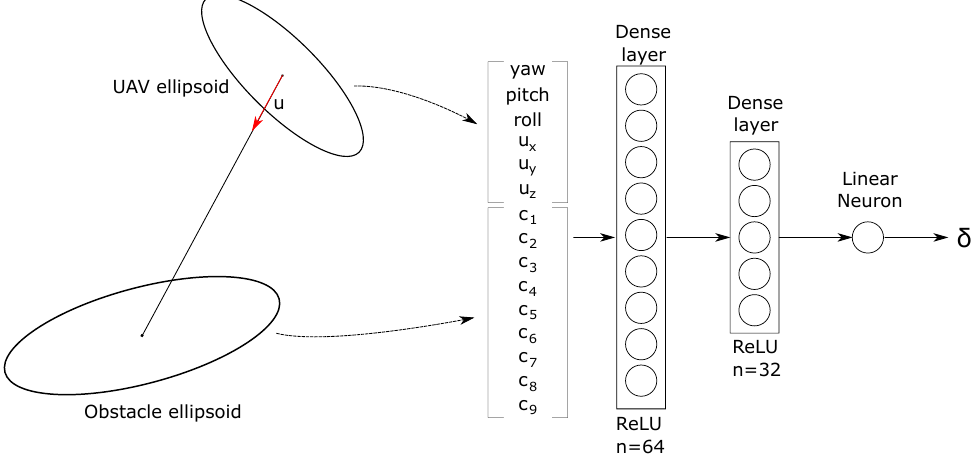
Figure 4. Neural network architecture.